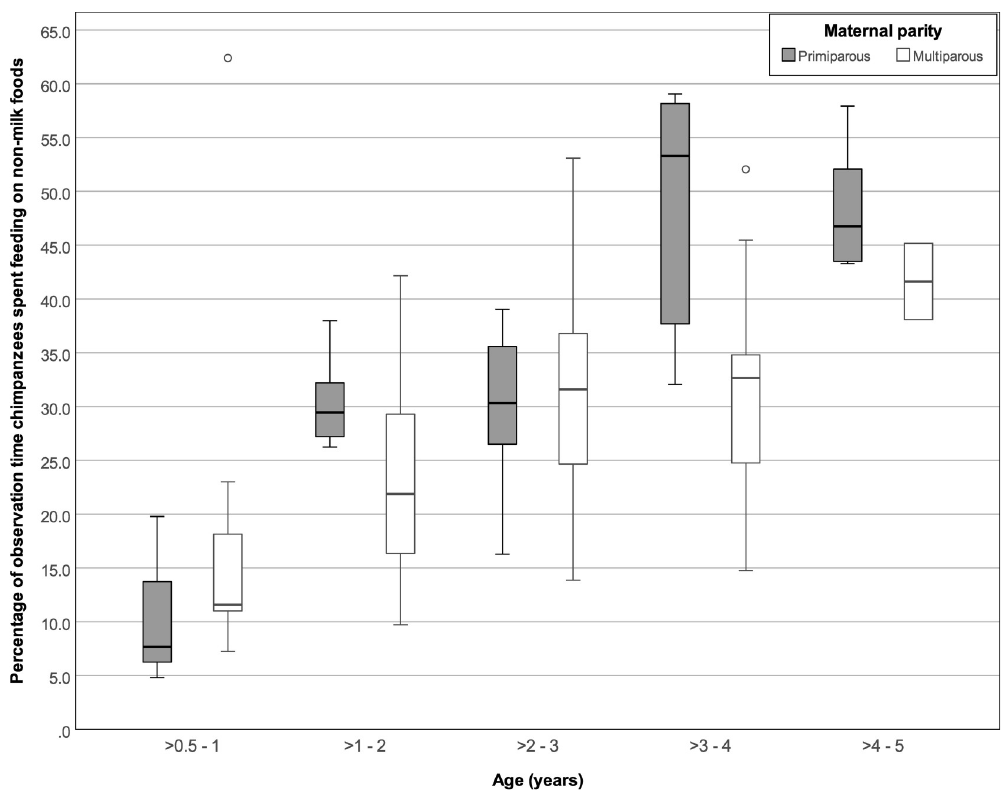
Fig 7. Percentage of focal observation time spent foraging by infants between 6 months and 5 years old of primiparous versus multiparous mothers. Box plots show median values (solid horizontal lines), 25th and 75th percentile values (box boundaries), highest and lowest values (whiskers) and outliers